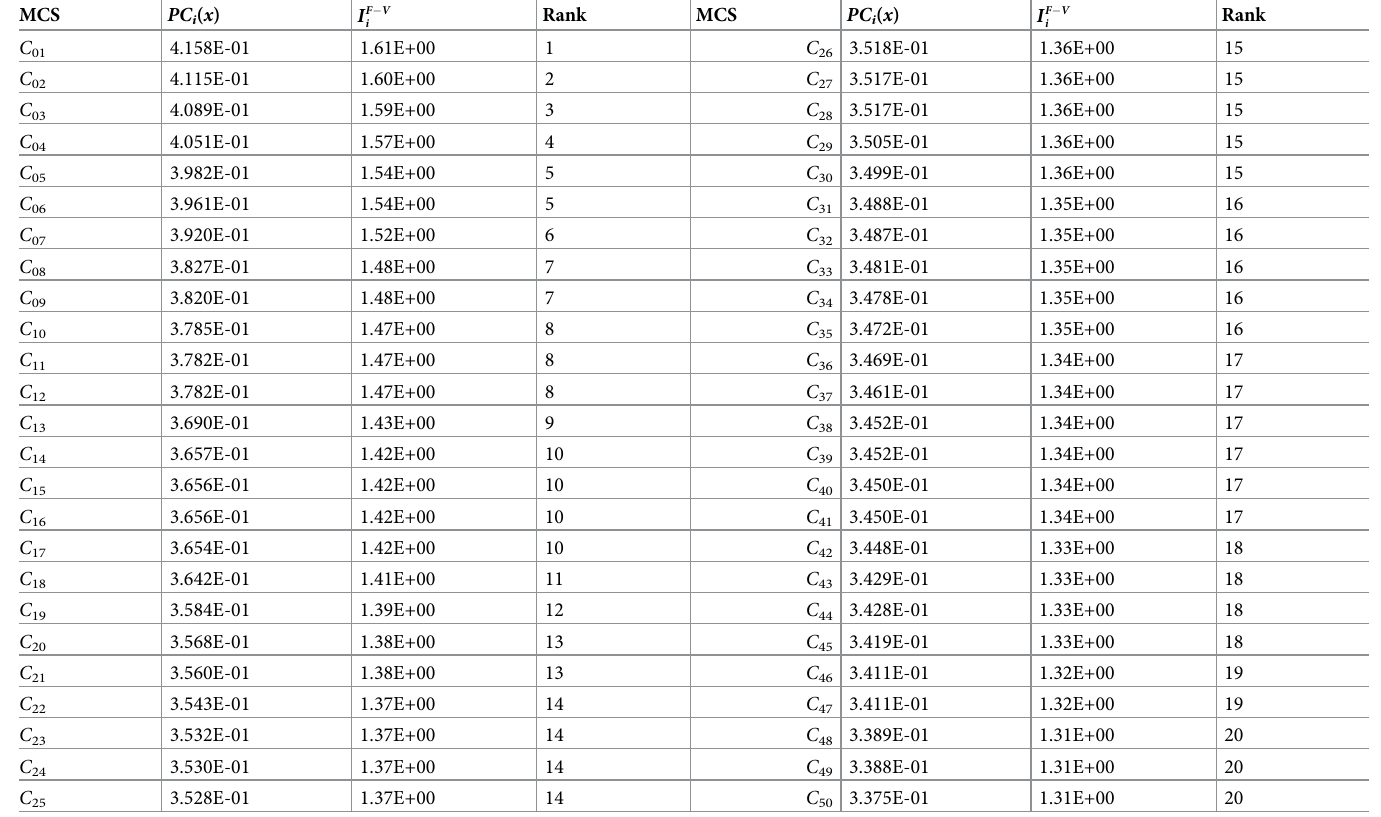
Table 6. FVI-based importance ranking of the top 50 MCSs in fire accident fault